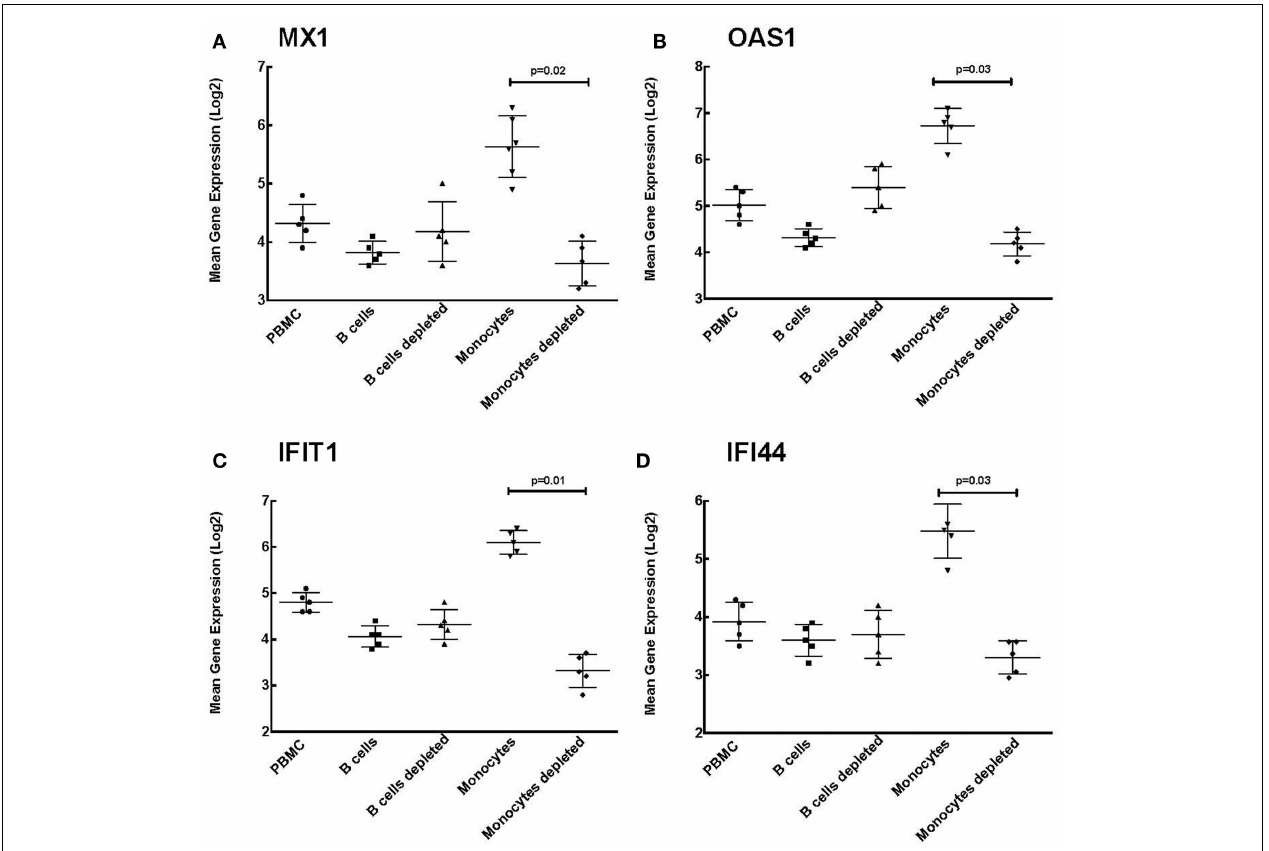
between monocyte depleted and enriched), OAS1 ( p = 0.03 between monocyte depleted and enriched), IFIT1 ( p = 0.01 between monocyte depleted and enriched), and IFI44 ( p = 0.03 between monocyte depleted and enriched), was significantly higher in monocyte enriched PBMCs compared to total PBMCs and monocyte depleted PBMCs, while no such differences were observed when B cells were